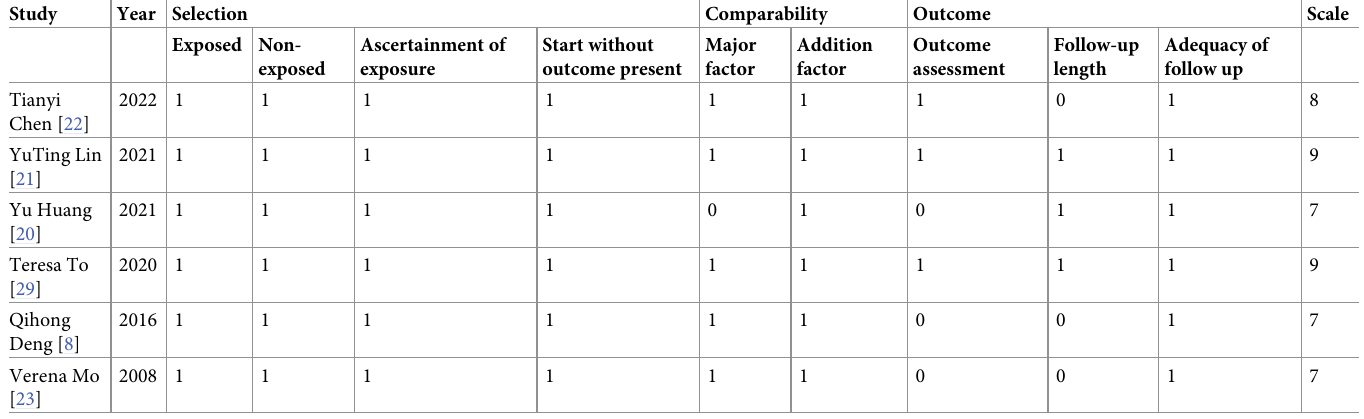
Table 2. Newcastle–Ottawa scale to evaluate the methodological quality of cohort studies included in the systematic